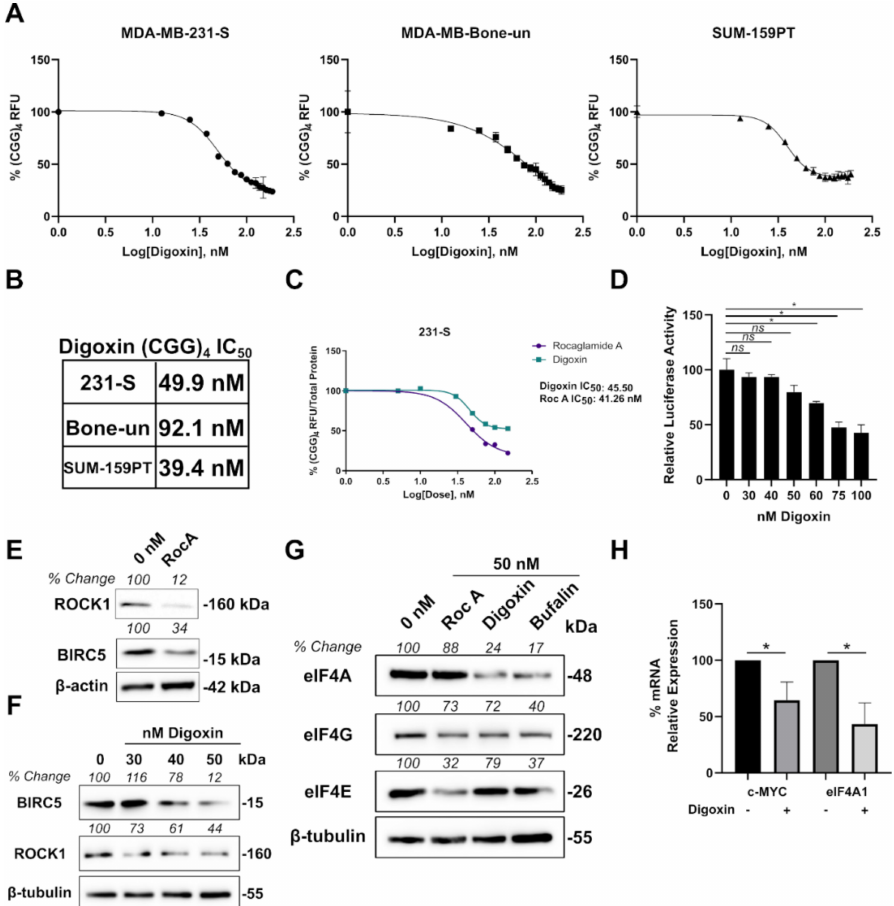
Figure 3. Cardiac glycosides inhibit eukaryotic translation initiation factor 4A complex (eIF4A)-dependent translation in triple-negative breast cancer (TNBC) cells. ( A ). (CGG) 4 Luc2-tdTomato readings in MDA-MD-231-S, MDA-MB-Bone-un, and SUM-159PT cells following treatment with 0-187.5 nM digoxin (12.5 nM increments). ( B ). Calculated (CGG) 4 IC 50 values for each cell line. ( C ). (CGG) 4 Luc2-tdTomato / total protein readings (A595) in MDA-MD-231-S cells following treatment with either 0-150 nM digoxin or rocaglamide A. ( D ). CMV-Luciferase / RTK Renilla expression readings in 293 cells following treatment with 0–100 nM digoxin (* indicates p < 0.05 as analyzed by a one-way ANOVA with a Bonferroni post hoc test). ( E ). Western blots following treatment with 50 nM rocaglamide A for 48 h in SUM-159PT cells. Band intensities were calculated by densitometry based on the ratio of each target gene (BIRC5 or ROCK1) normalized to the β -actin protein signal with 0 nM set to 100. ( F ). Western blots following treatment with 0–50 nM digoxin for 48 h in SUM-159PT cells. Band intensities were calculated based on the ratio of each target gene (BIRC5 or ROCK1) normalized to the β -tubulin protein signal with 0 nM set to 100. ( G ). Western blots following treatment with 50 nM of each indicated drug for 72 h in SUM-159PT cells. Band intensities were calculated based on the ratio of each target gene (eIF4A, eIF4G, or eIF4E) normalized to the β -tubulin protein signal with 0 nM set to 100. Uncropped Blots are shown in Figure S2. ( H ). Quantitation of mRNA levels by qPCR from SUM-159PT cells following the treatment of 50 nM digoxin. Data were analyzed using the ∆∆ Ct method with β -tubulin as the control. Relative expression was calculated with DMSO-treated cells set to 100% (* indicates p < 0.05 as analyzed by a one-way ANOVA with a Bonferroni post hoc